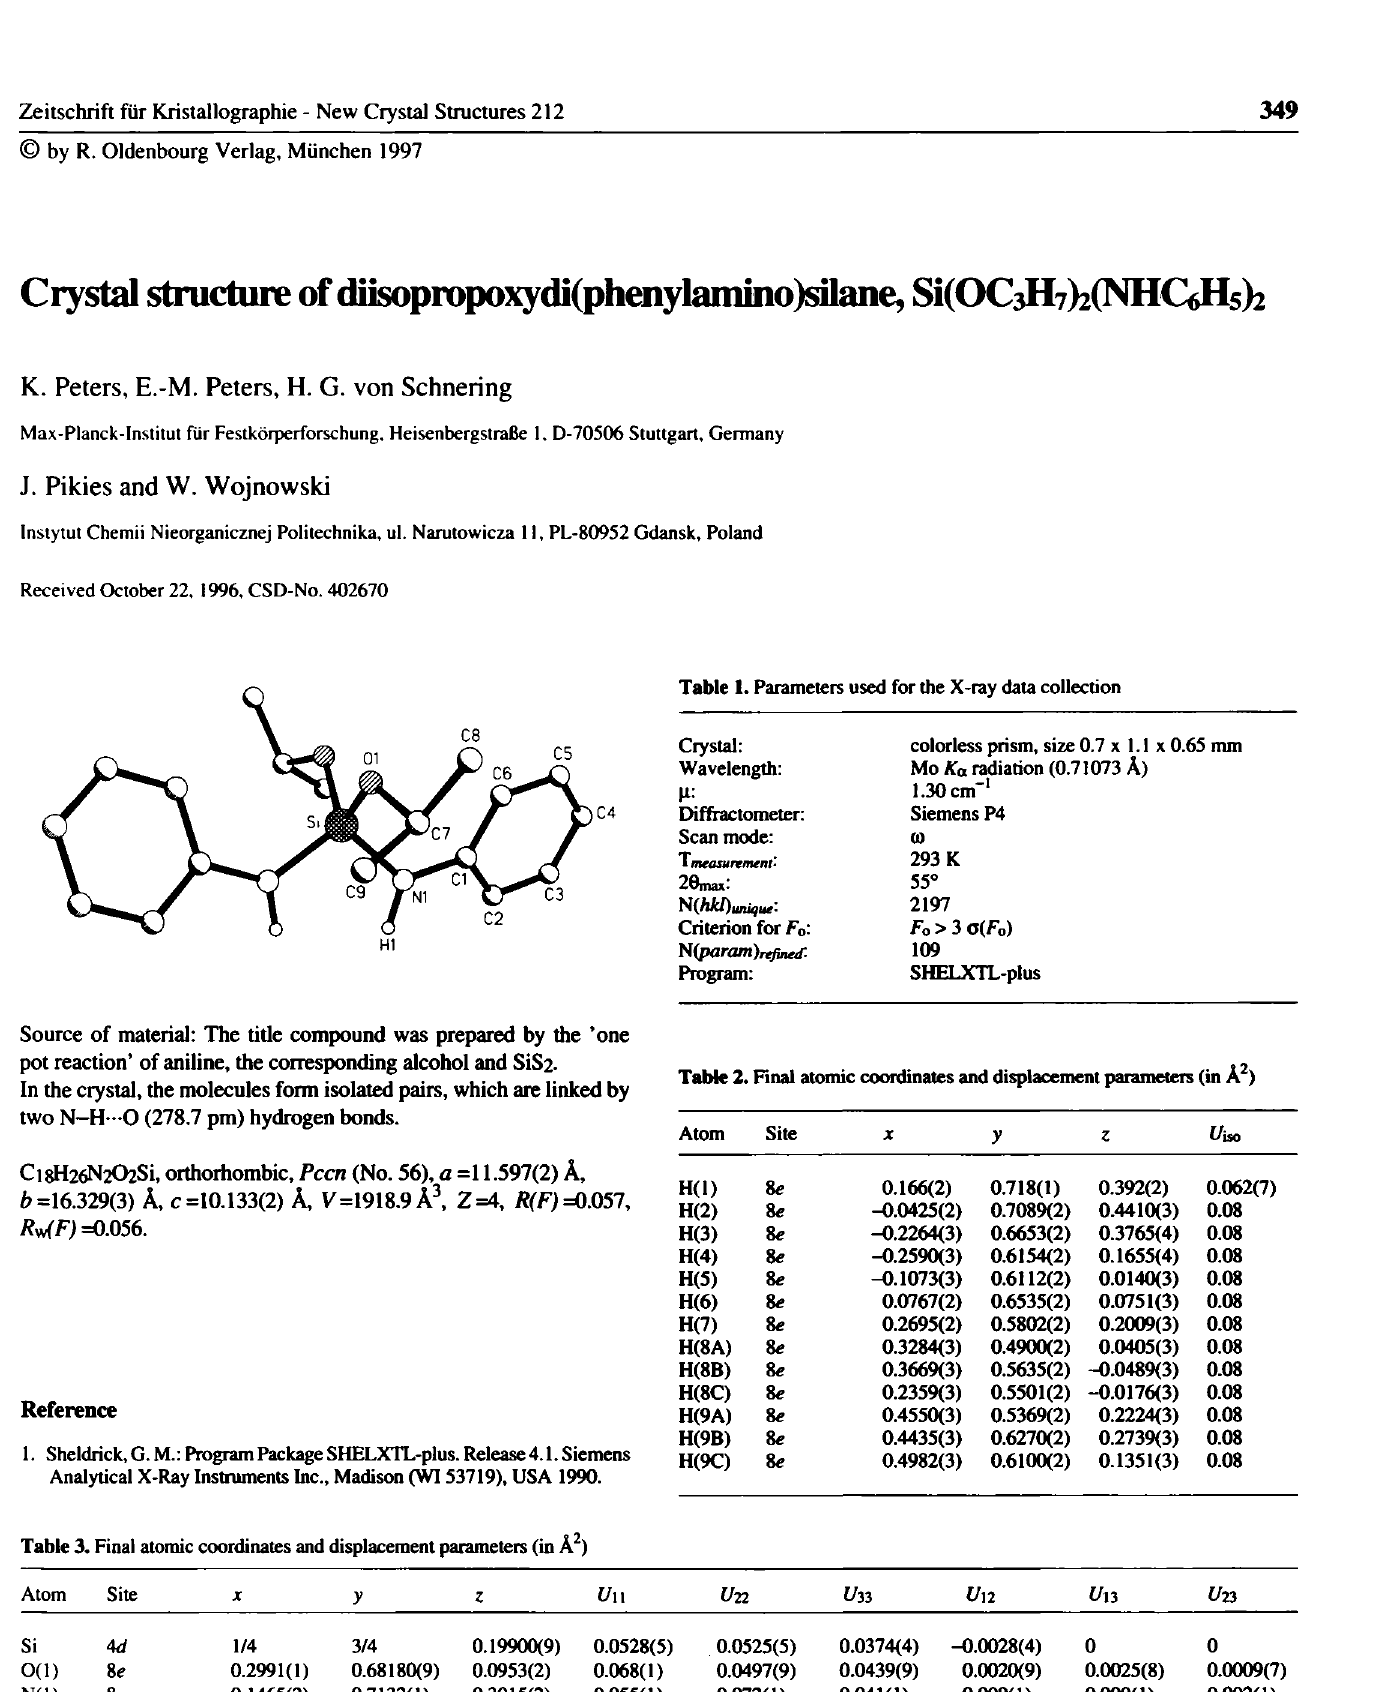
Table 3. Final atomic coordinates and displacement parameters (in Â 2 ) Atom